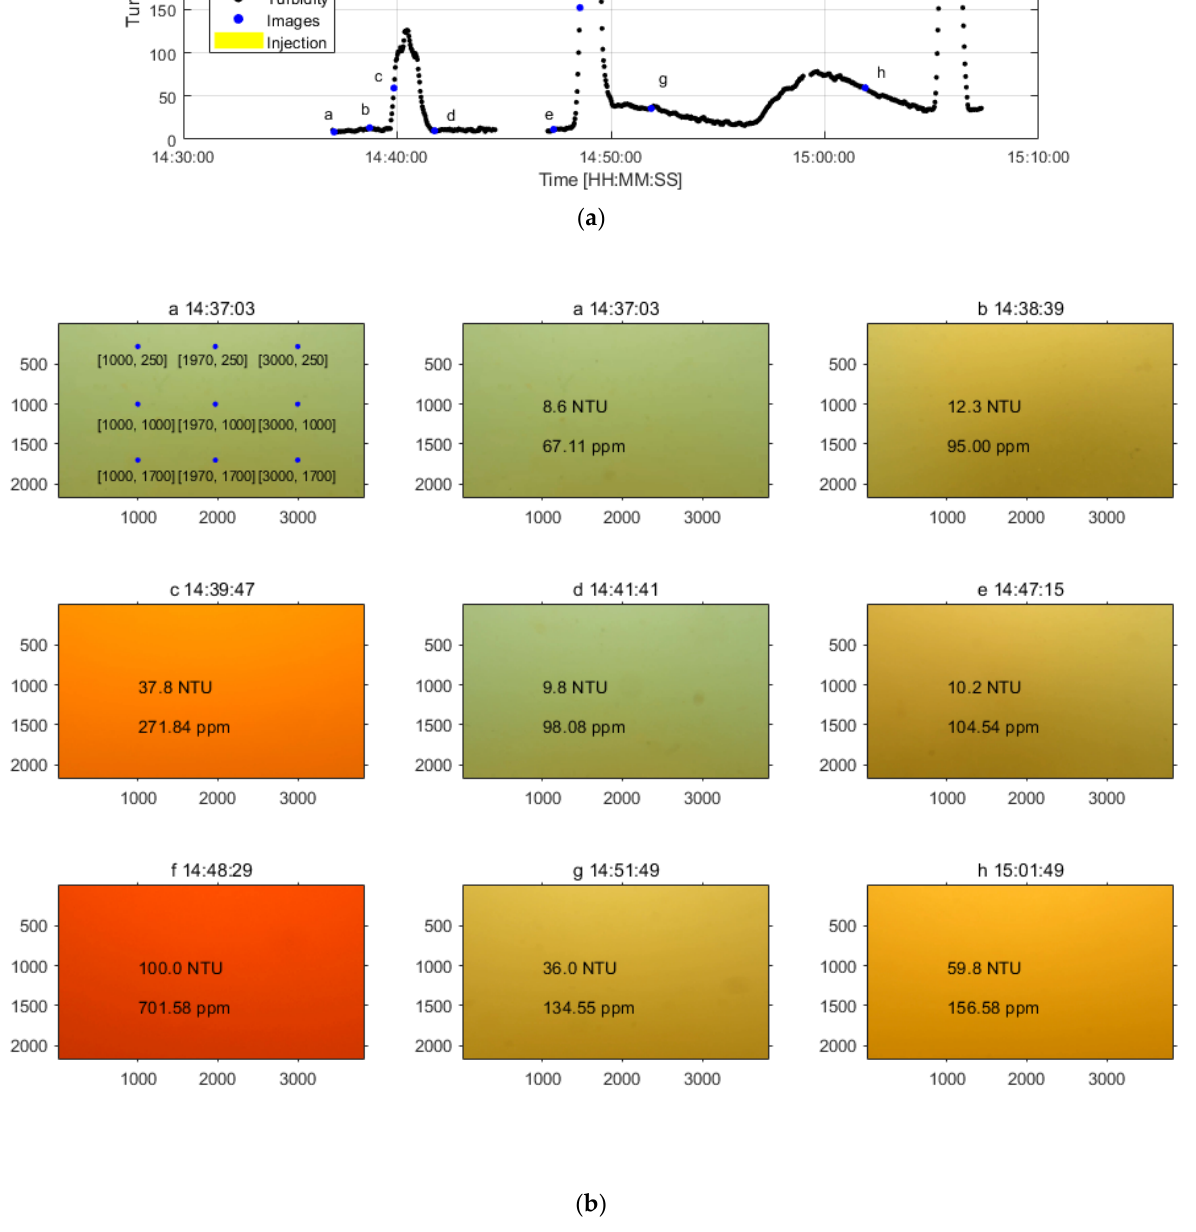
Figure 7. ( a ) Turbidity measurement results and ( b ) color changes in underwater images due to the changes in suspended sediment concentration and turbidity.